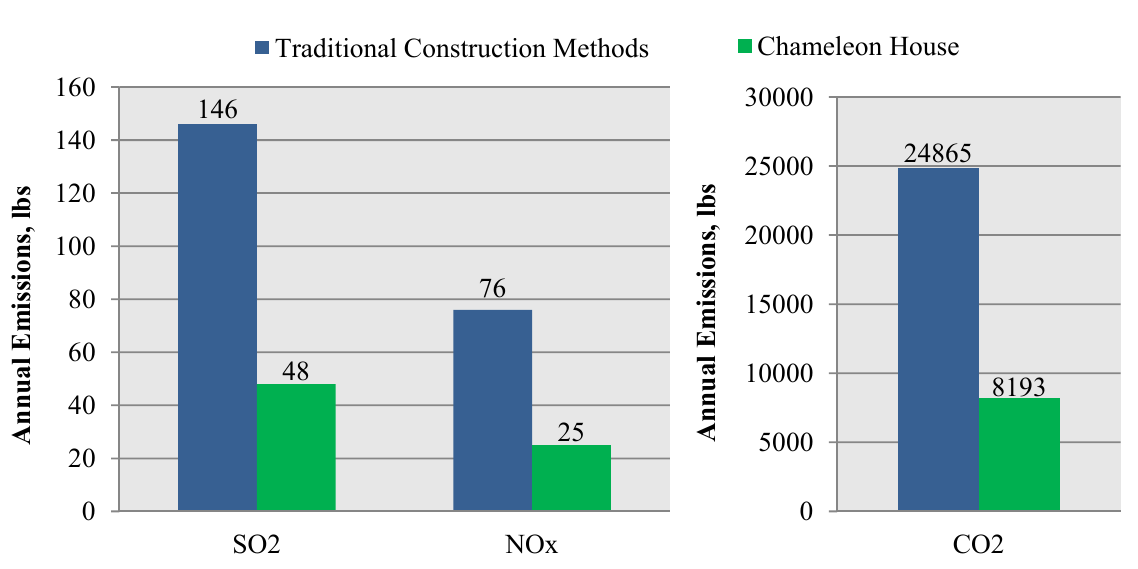
Figure 7. Annual emissions results—Not accounting for PV